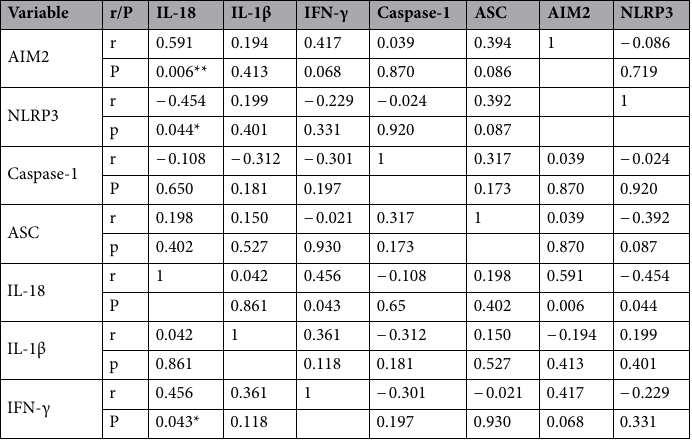
Table 4. Acute brucellosis correlation analysis of inflammasome and inflammatory cytokines. * P < 0.05 ** P < 0.01.